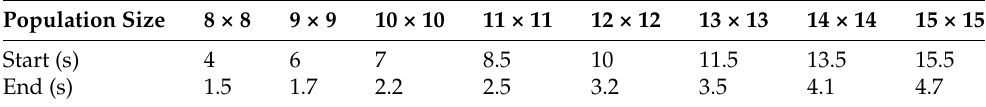
Table 1. The delay of parallel GA models caused by parallelization using SCOOP.